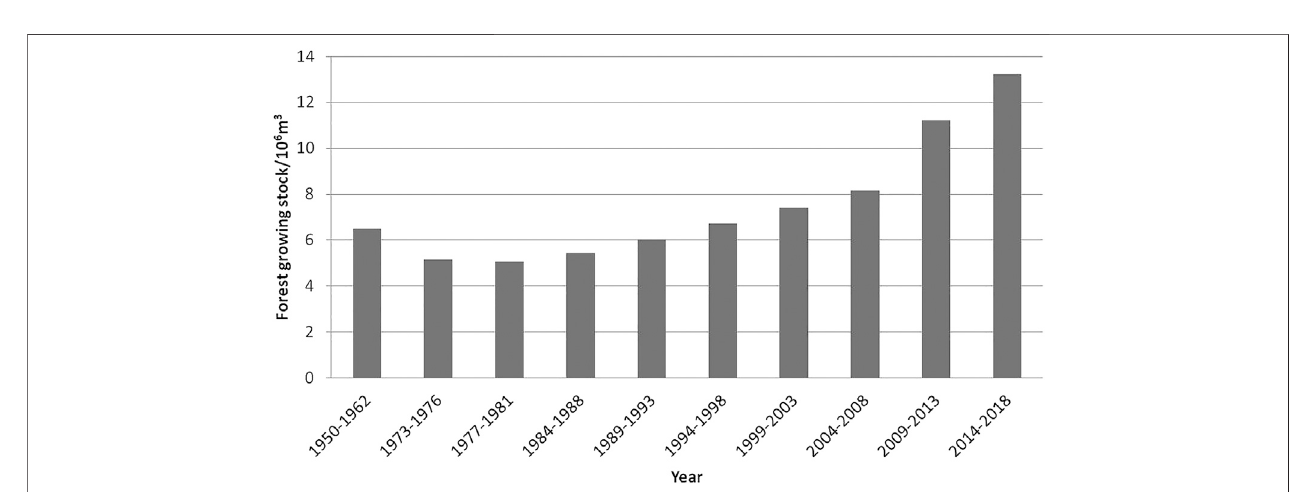
FIGURE 3 | Forest growing stock changes in Northwest